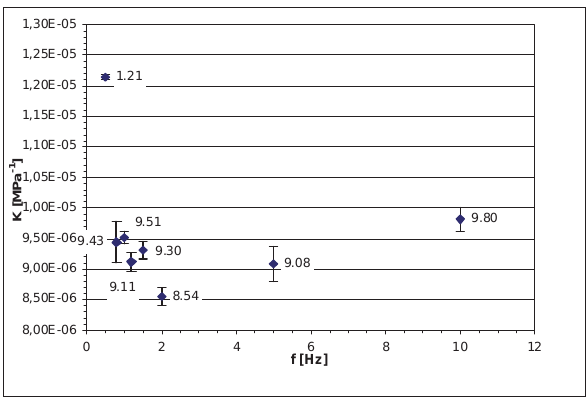
Fig. 7. Thermoelastic constant vs. frequency